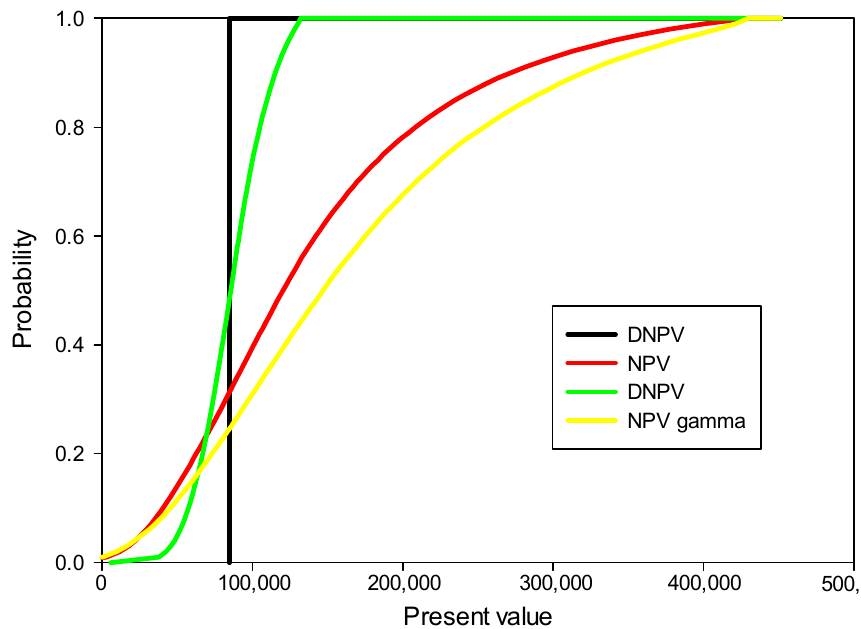
Figure 6. Probability of obtaining the indicated net present value (NPV) or a lower NPV (V = NPV, D = decoupled net present value (DNPV), g = use of gamma discount function).